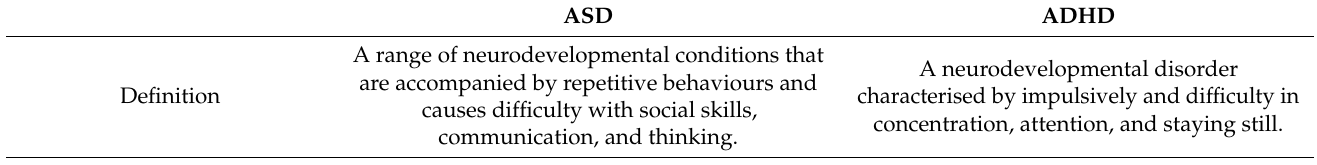
Table 3. ASD and ADHD characteristics. Differences and similarities between ASD and ADHD are presented. In addition, conditions that resemble ASD or ADHD are included. ASD ADHD A neurodevelopmental disorder are accompanied by repetitive behaviours and characterised by impulsively and difficulty in causes difficulty with social skills, concentration, attention, and staying communication, and thinking.